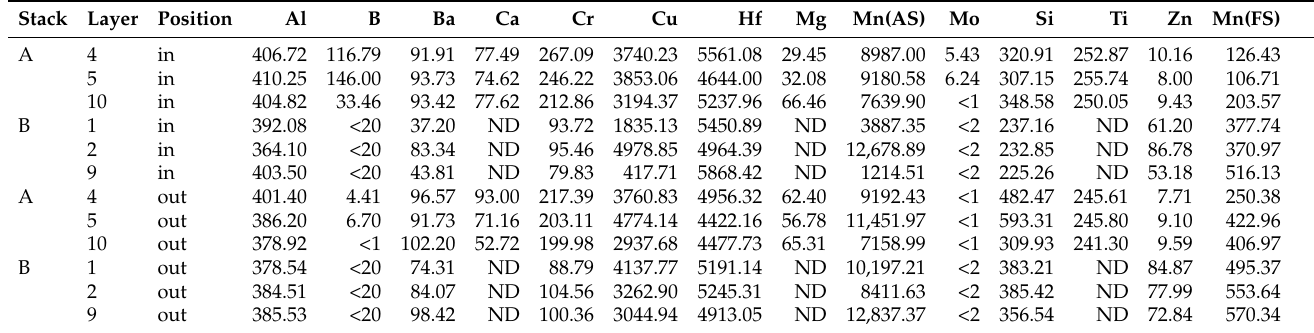
Table A2. Concentrations in µgg − 1 determined in cell samples after operation (boron from perchlo- rate digestion only, Mn(AS) from perchlorate digestion, Mn(FS) from digestion with lithium borate, other species as sum of